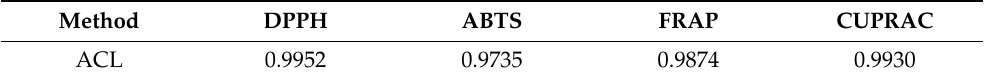
Table 5. Correlation coefficients between ACL and DPPH, ABTS, FRAP, and